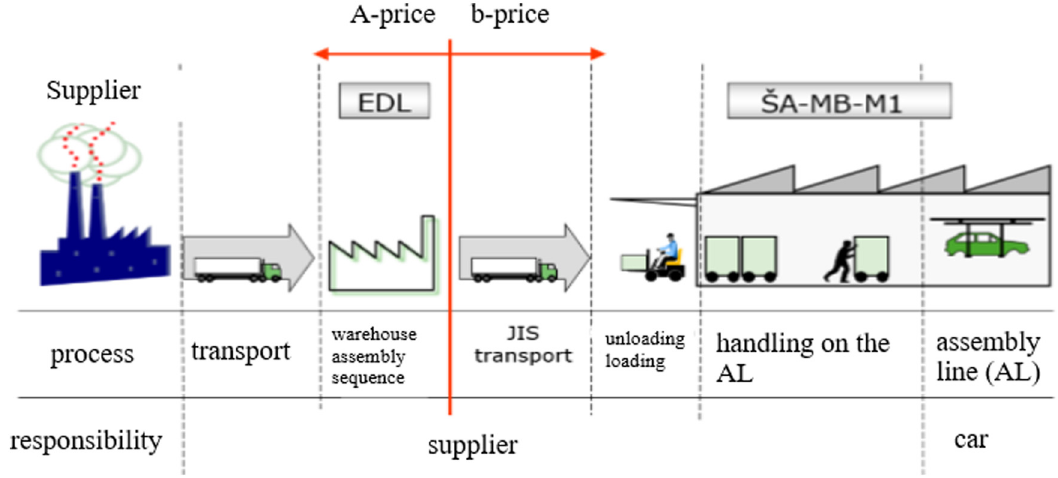
Figure 6: JIS C diagram. Source: ref. [ 14 ]